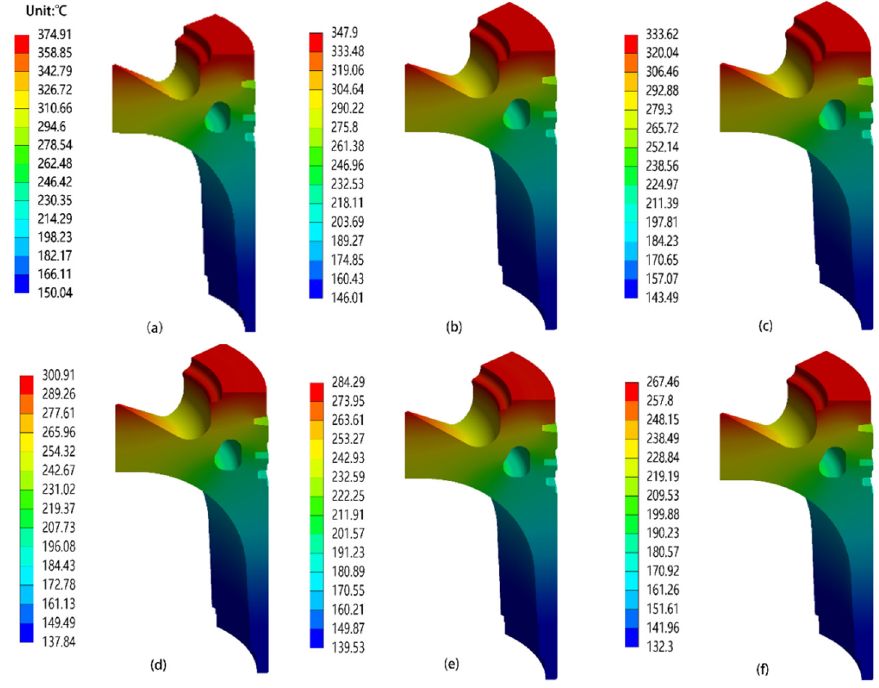
Figure 12. Temperature distributions of piston substrates coated using different thicknesses. ( a ) shows the temperature field of the unpainted piston, and ( b – f ) shows the temperature field of the piston aluminum alloy substrate with the total coating thickness of 0.3 mm, 0.4 mm, 0.6 mm, 0.8 mm and 1.0 mm.